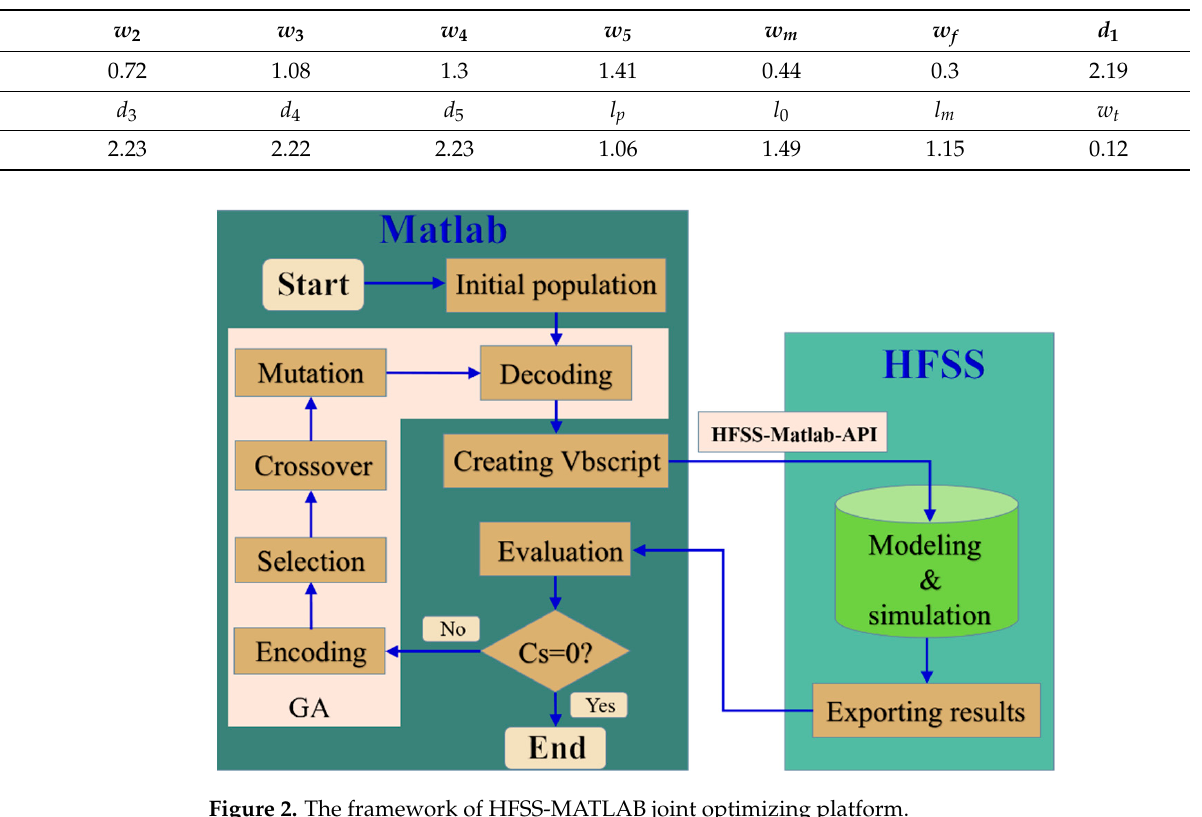
Figure 2. The framework of HFSS-MATLAB joint optimizing platform. Table 1. The dimensions of the optimized series-fed patch antenna array. (Unit: mm).